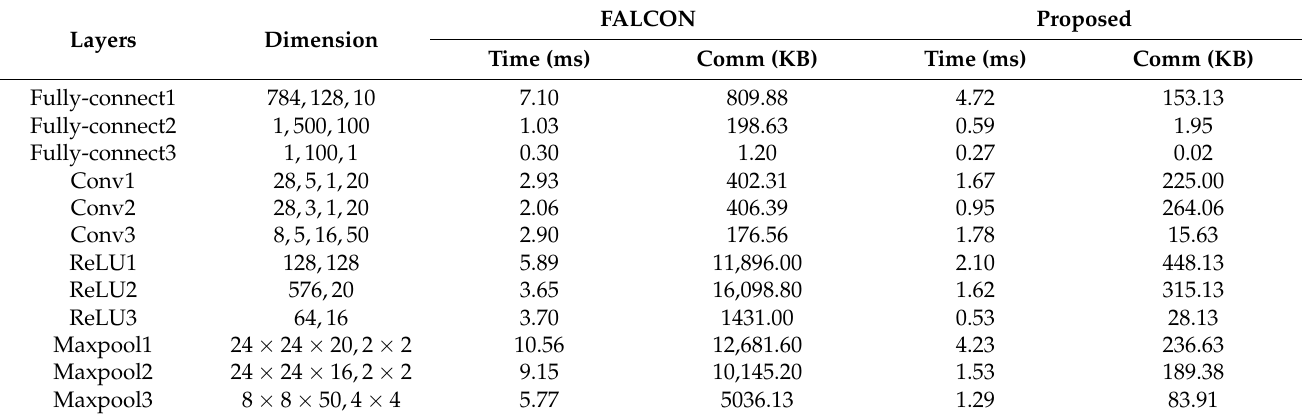
Table 4. Microbenchmarks in malicious